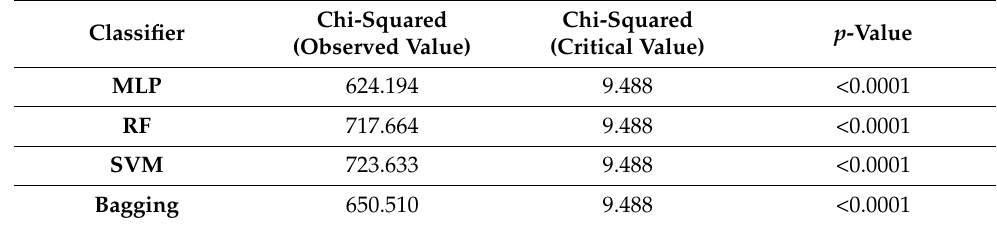
Table 8. Contingency table showing the chi-squared values and the p-value for each